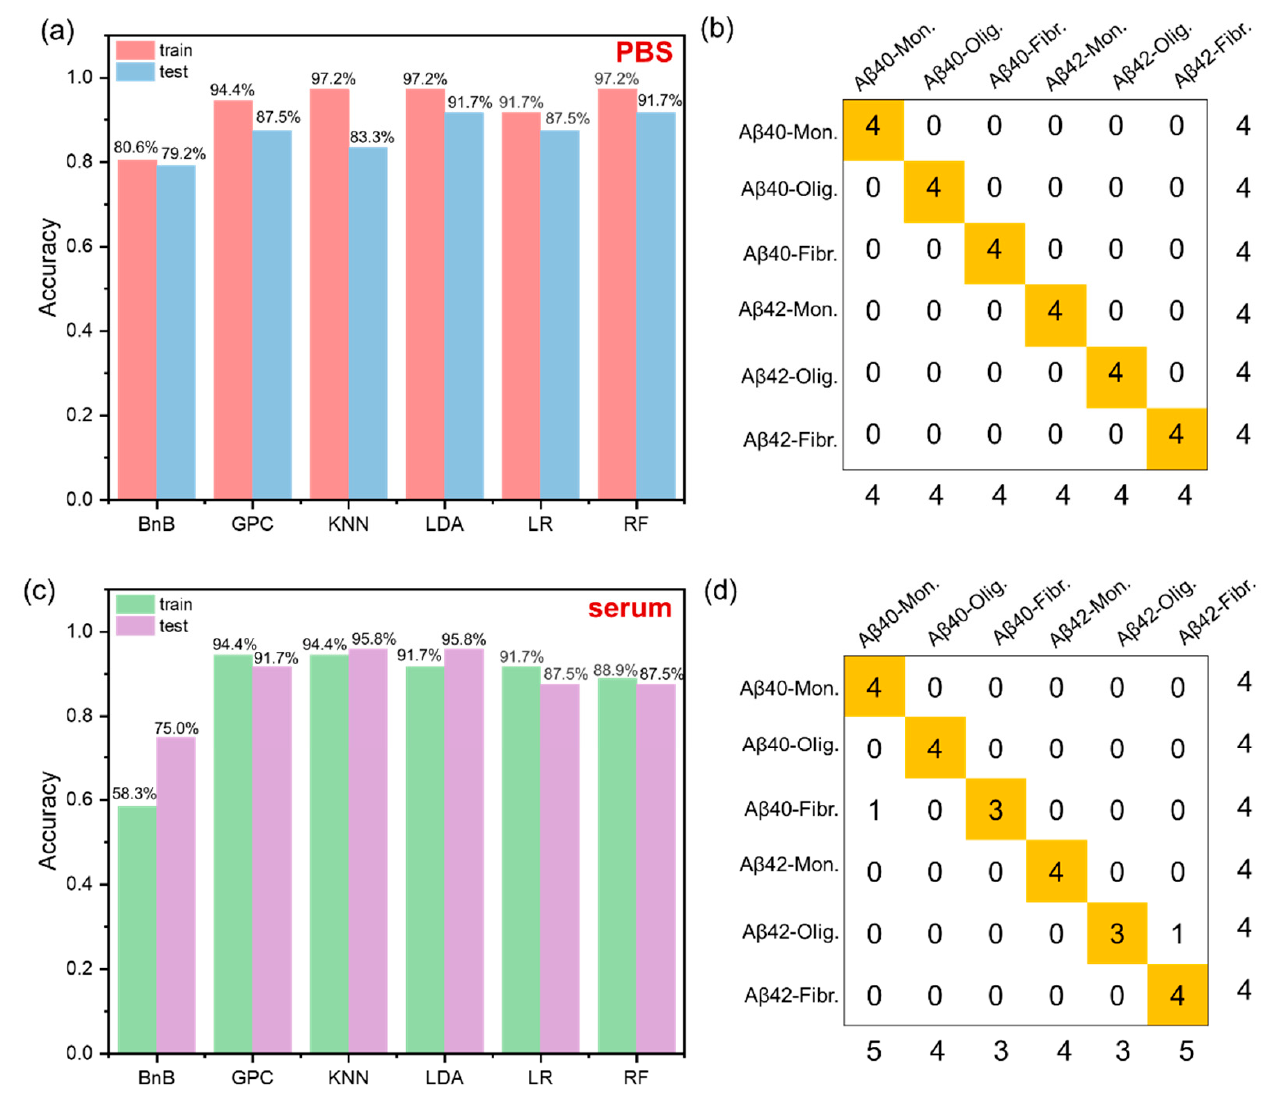
Figure 5. ( a ) Usage of machine learning (ML) methods and classical statistical method LDA for pattern recognition of 1 µ M Amyloid- β protein by 6 channels in PBS. ( b ) Confusion matrix plot of the output of the classifier from the LDA results by SYSTAT (version 13.0) for unknown sample detection. ( c ) Usage of machine learning (ML) methods and classical statistical method LDA for pattern recognition of 1 µ M Amyloid- β peptides by 6 channels in serum. ( d ) Confusion matrix plot of the output of the classifier from the KNN results for unknown sample detection.